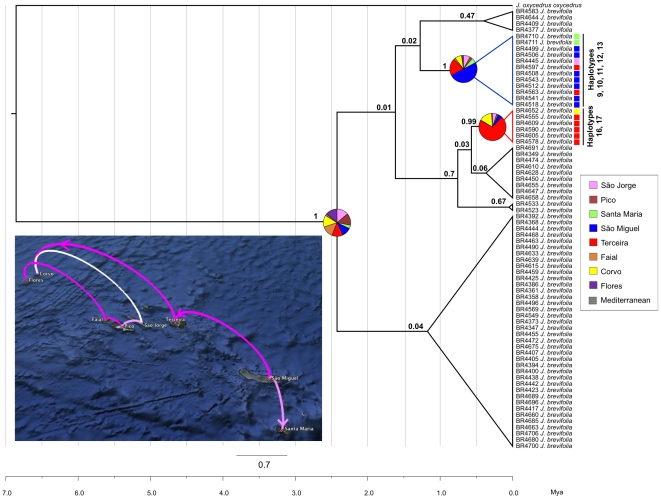
Relaxed molecular-clock chronogram and phylogeographic reconstruction of Juniperus brevifolia.
Maximum clade credibility tree summarized from the geospatial Bayesian analysis of cpDNA (petN-psbM, trnS-trnG and trnT-trnL sequences) of 71 individuals of J. brevifolia. Pie charts represent posterior probability distributions of ancestral range at well-supported nodes of interest. Colored rectangles represent the sample's island of origin. The haplotype relatedness is also shown in the well-supported clades. Colonization routes supported by a BF>3 are shown on the map. The color of each route represents its relative support, with more intense colors indicating stronger support. Arrows specify directionality in the colonization route, inferred from well-supported nodes of interest in the geospatial Bayesian analysis. The map is based on satellite images available in Google Earth (http://earth.google.com).